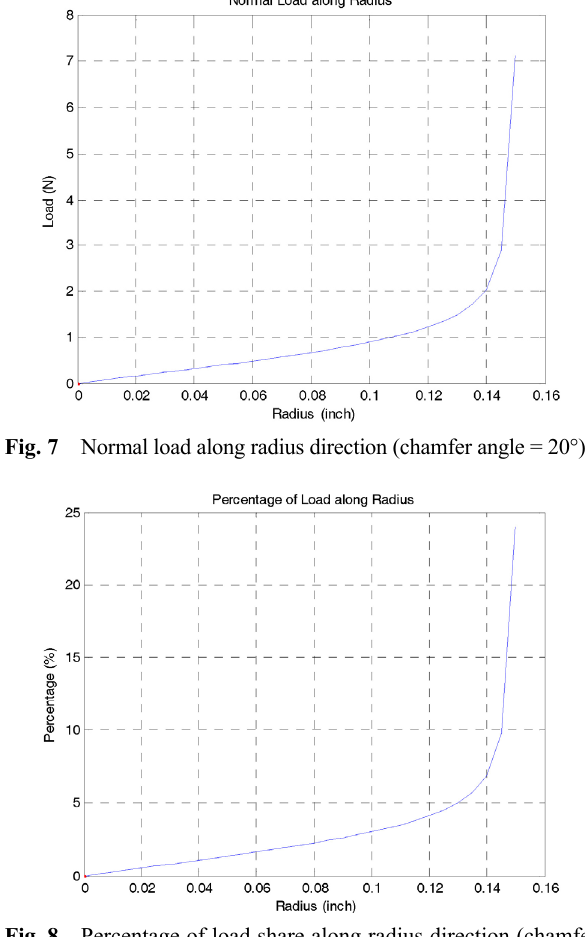
Fig. 8 Percentage of load share along radius direction (chamfer angle = 20  ).